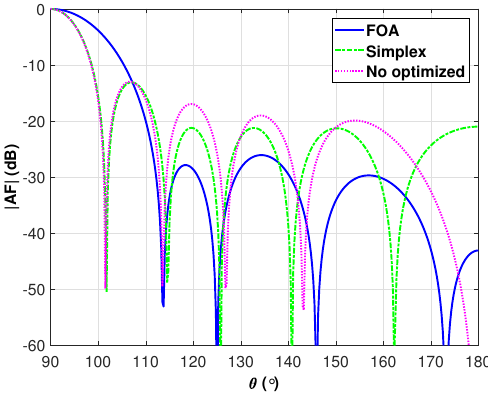
Figure 5. Array factor of the second